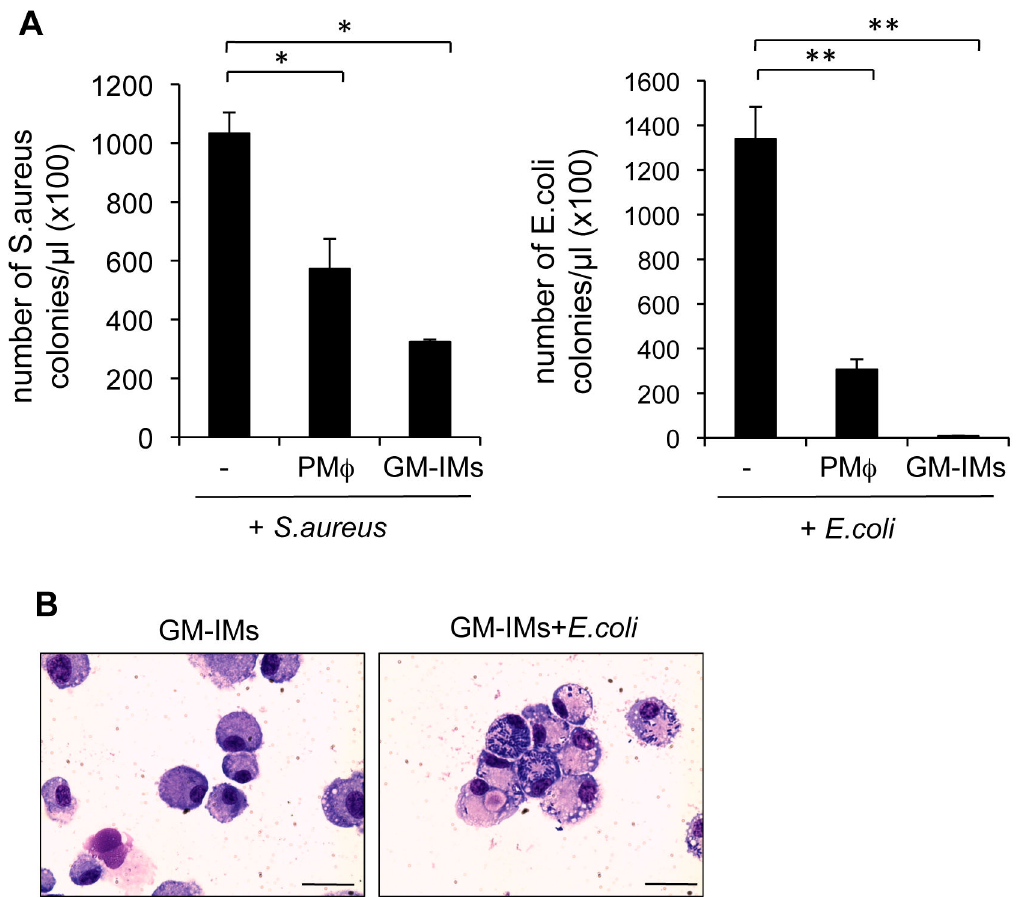
Figure 5. Functional analysis of GM-IMs. (A) Bacterial killing assay. S. aureus (left) or E. coli (right) were serially diluted in 96- well plates. They were mixed with 5 x 10 4 PMφ or GM-IMs and cultured overnight in 100 µL RPMI-1640 and 10% FCS and 3% GM- CSF-CM. One µL of mixed culture at appropriate dilution (which showed the clear differences in the number of bacteria) was plated on an agar plate. After 24 hr, the number of colony forming units (CFU) was counted. Data shown are the mean ratios ± SE of three independent experiments. P value: * <0.01,